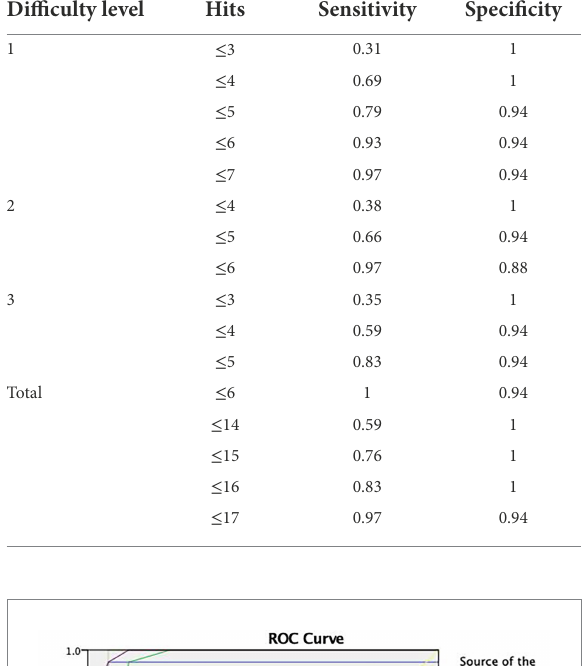
TABLE 5 Sensitivity and specificity of CIH-EV cut-off points for older adults with dementia. Difficulty